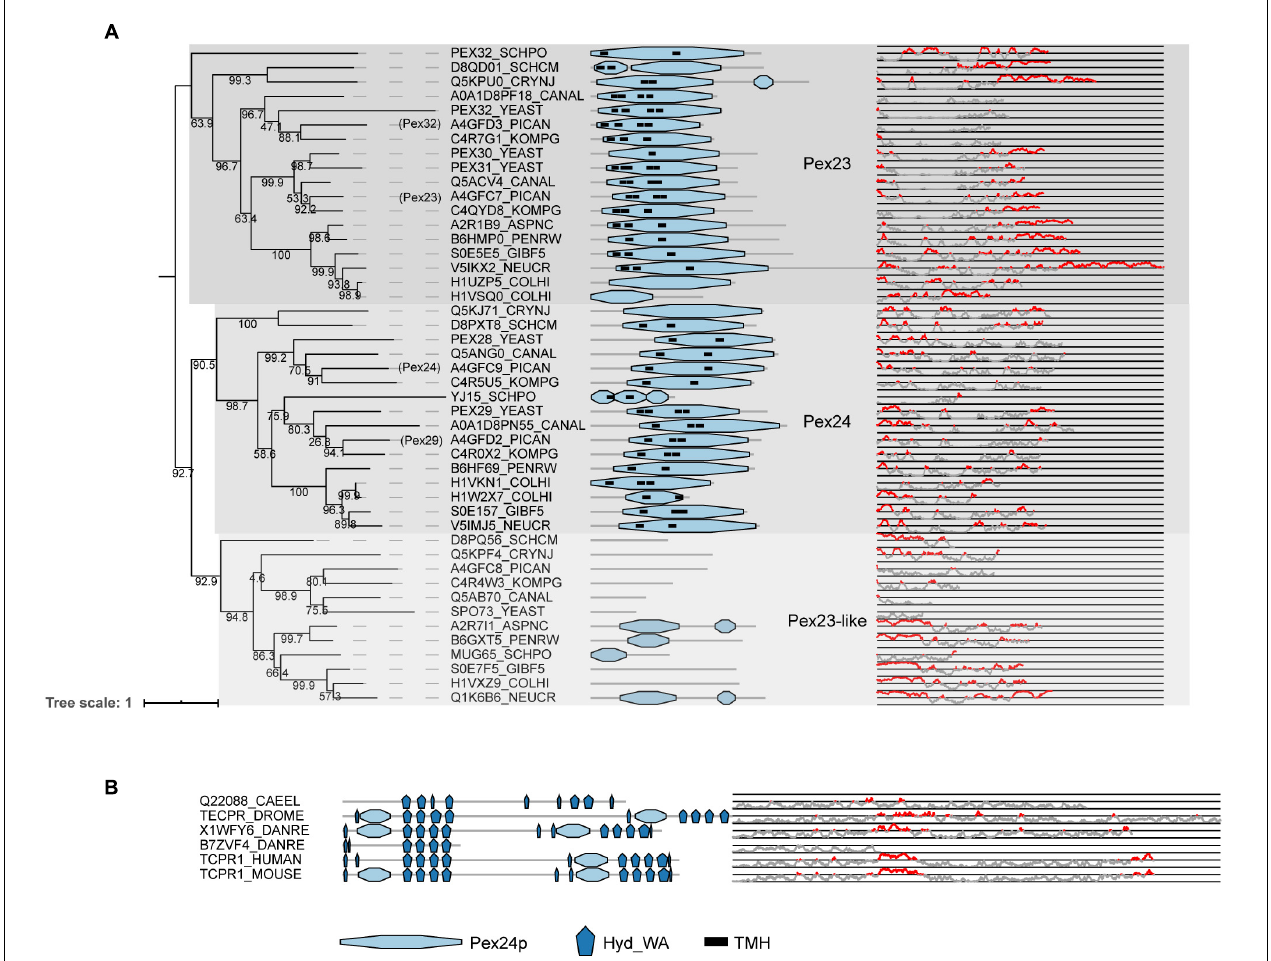
FIGURE 7 | Phylogeny and protein features of Pex23 protein family and TECPR1 proteins. (A) Phylogeny and protein features of the fungal Pex23 protein family. The phylogeny is rooted at mid-point to ease the visualization. The main phylogenetic groups are named and highlighted according the protein names of O. polymorpha , indicated between brackets. Protein domain architecture is defined by pfam annotations and transmembrane helix according to TMHMM software. The Pex24p pfam domain contains the DysF motifs. The line-dot plot, indicates the region predicted be disordered (red) and not disordered (gray). (B) Protein features of TECPR1 protein family from